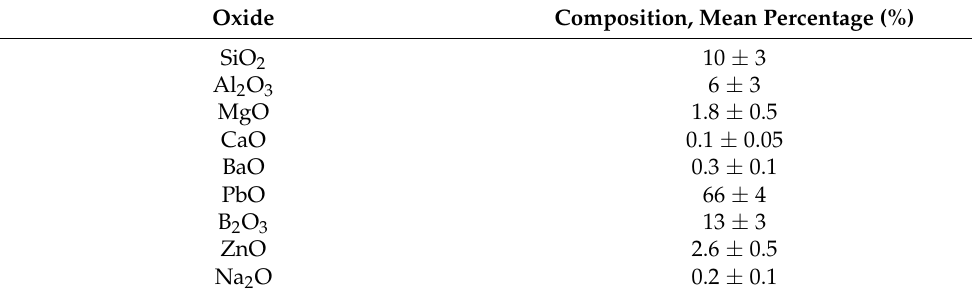
Table 1. Oxide content as a percentage for the gf material.